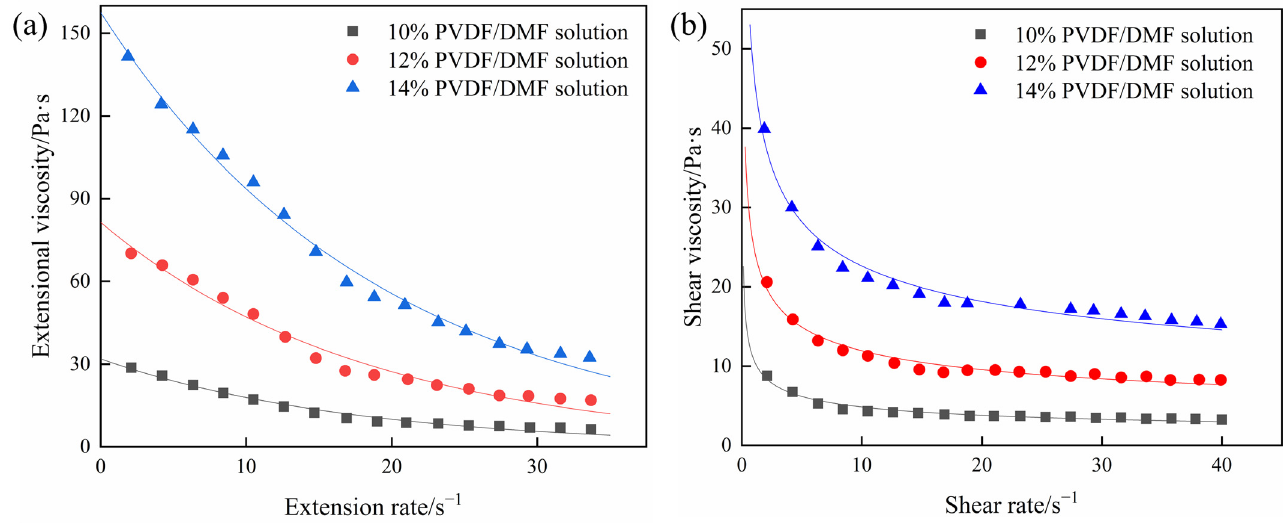
Figure 7. The viscosities of PVDF/DMF solutions: ( a ) extensional viscosity and ( b ) shear viscosity.